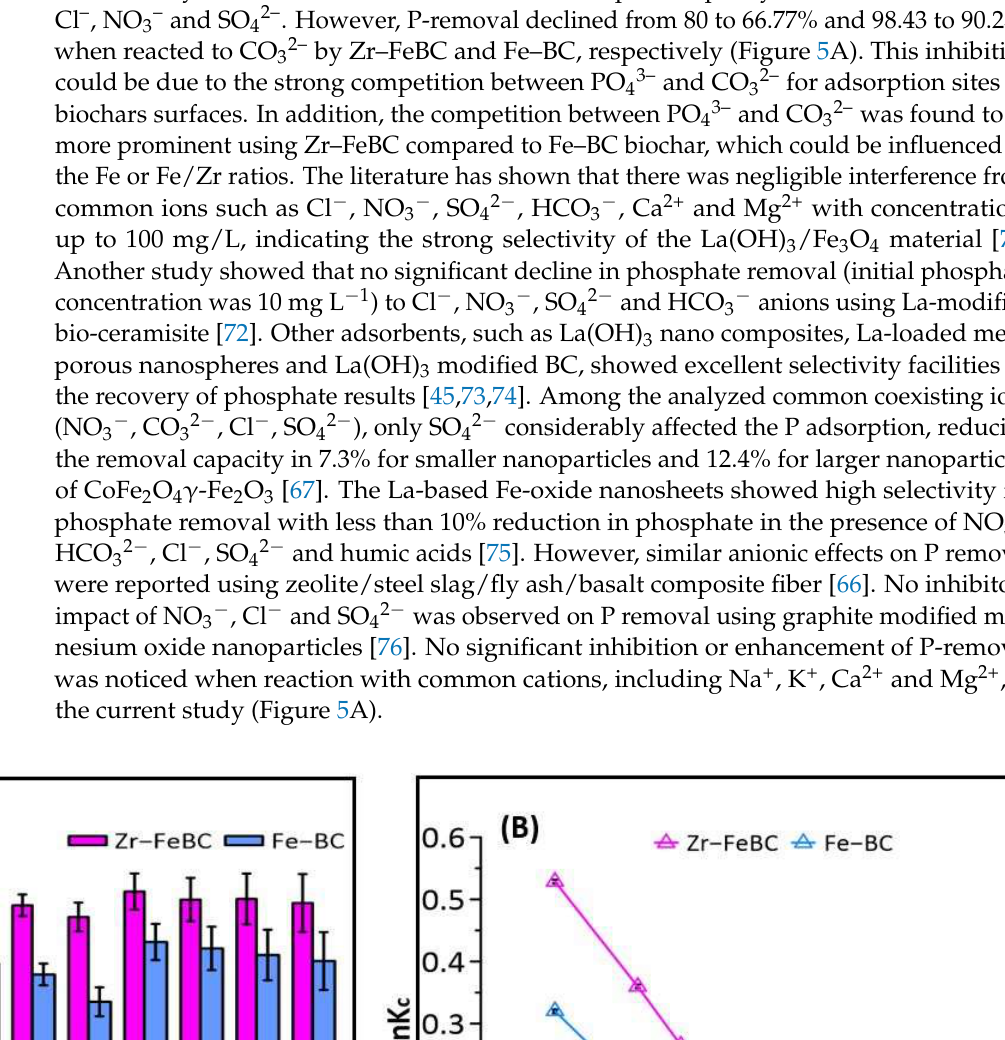
Table 4. Thermodynamic parameters for the P adsorption on biochars.